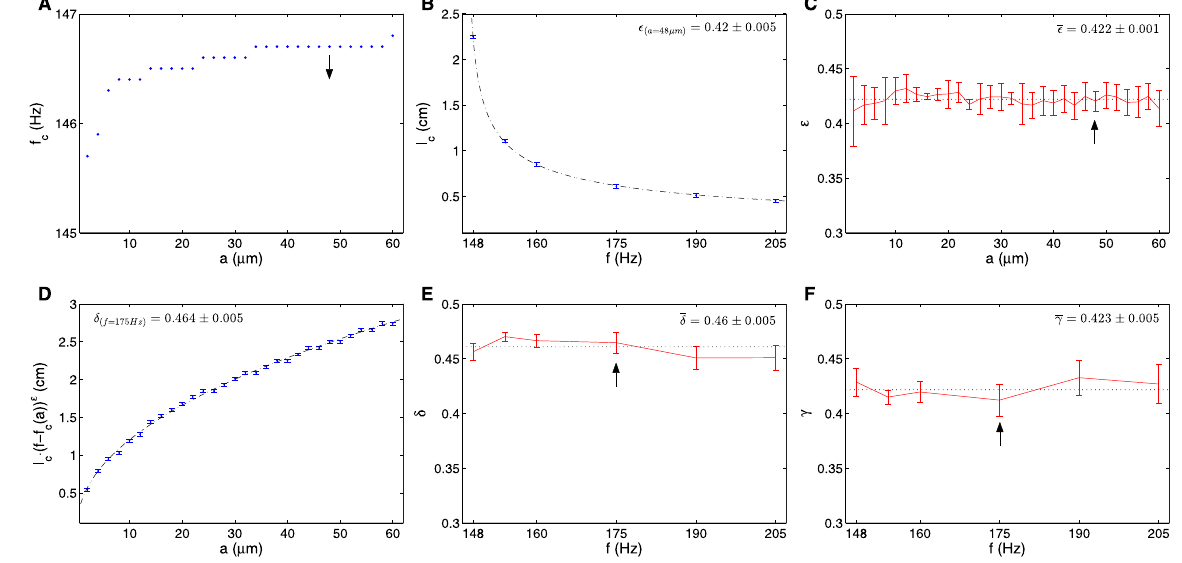
Figure 3. Parameter estimation of the phenomenological equation that describes the transition between propagating train and coded firing patterns. ( A ) Direct measurements of the maximum frequency ( f c ) that enables propagation of uninterrupted train in long axons (10 cm) for a range of axonal radii. Arrow indicates radius value used in ( B ). ( B ) Fitting the dependency between l c and f for a = 48 µ m. Dashed line is the fitted curve: . ⋅ − . − . f 2 517 ( 146 7) 0 42 . Bars correspond to numerical measurement errors determined by the sampling interval of the phase plain: Δ l = 0.02 cm . ( C ) Fitted ε ’s for all studied radii. Arrow indicates ε value calculated in ( B ). ( D ) Fitting the dependency between ⋅ − ε l f f a ( ( )) and a for f = 175 Hz. Dashed line is the fitted curve: c c 0 464 . Bars correspond to numerical measurement errors determined by the sampling . ⋅ − ⋅ ε − . f f a a 0 4122 ( ( )) c interval of the phase plain: Δ l = 0.02 cm . ( E , F ) Fitted δ ’s ( E ) and γ ’s ( F ) for all studied frequencies. Arrows indicate the δ and γ values calculated in ( D